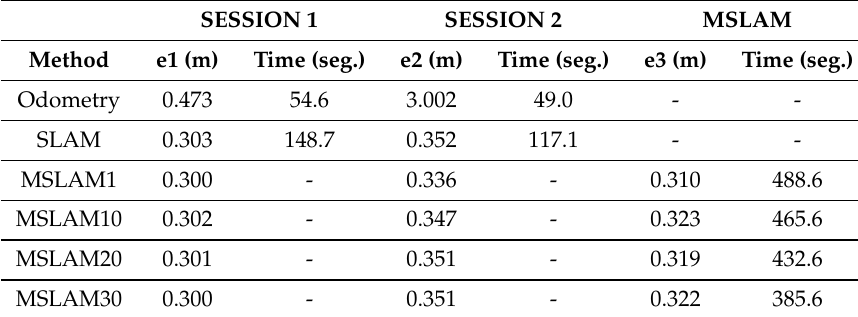
Table 1. Summary of the